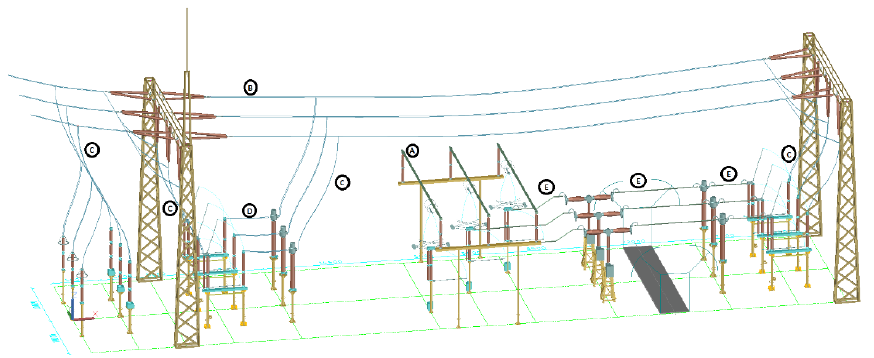
Figure 2. Section of a 400 kV switchyard with switching devices operating in a 3/2 W system.